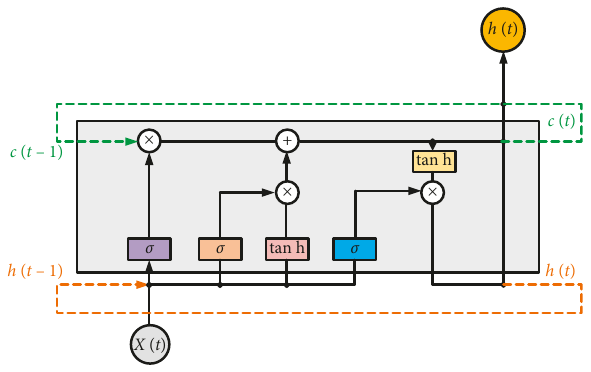
Figure 5: The schematic diagram of LSTM architecture.